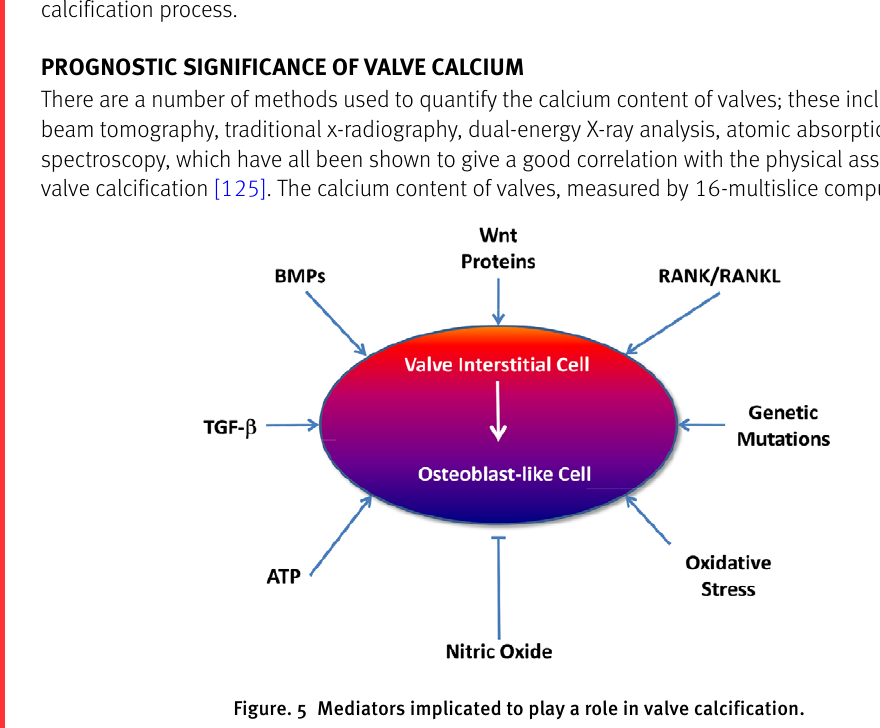
Figure. 5 Mediators implicated to play a role in valve calcification.